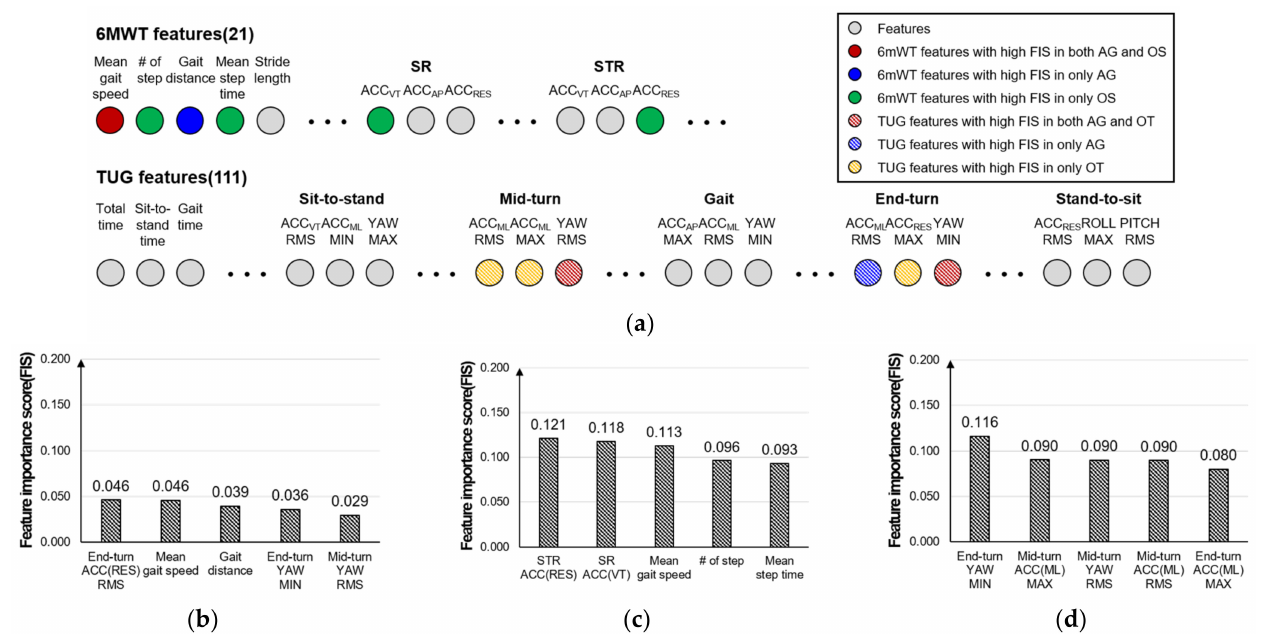
Figure 6. Analysis of feature importance in each of the XGBoost models as the dataset: ( a ) key features for each XGBoost model as the dataset; ( b ) AG; ( c ) OS; ( d )